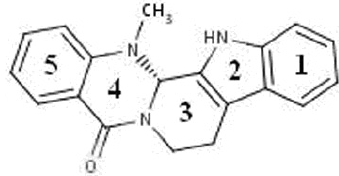
Figure 1. Structure of